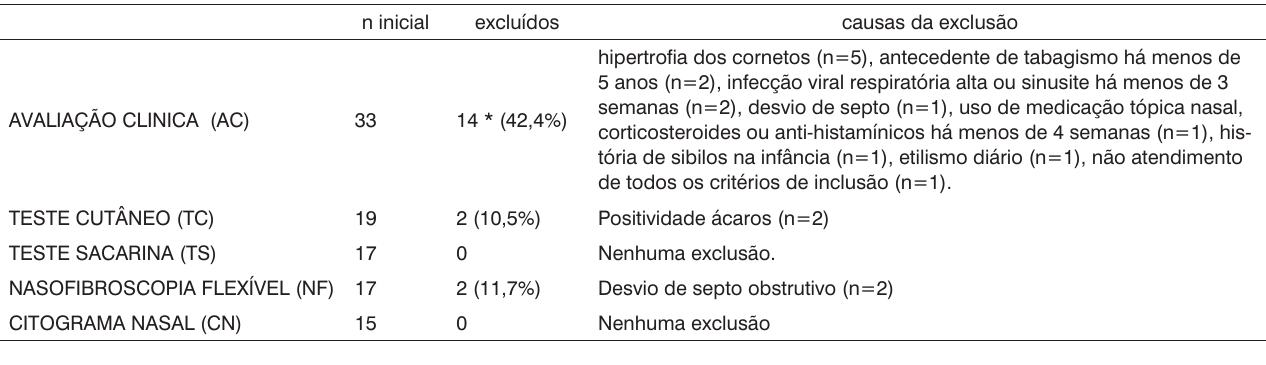
Tabela 6. Causas de exclusão por fases do